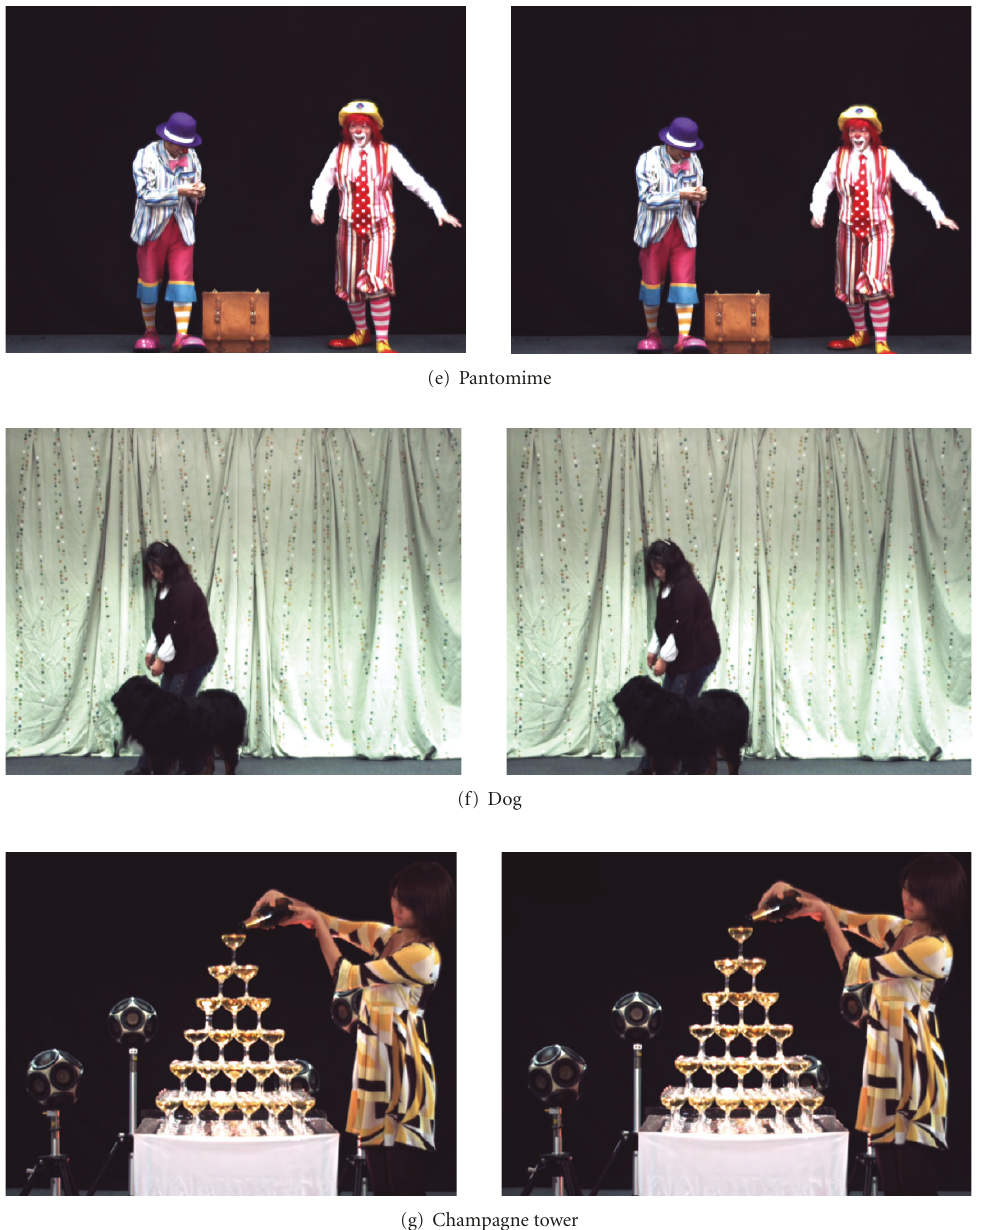
Figure 18: Subjective and objective quality comparison of the reconstructed images (Left: JMVM, Right: